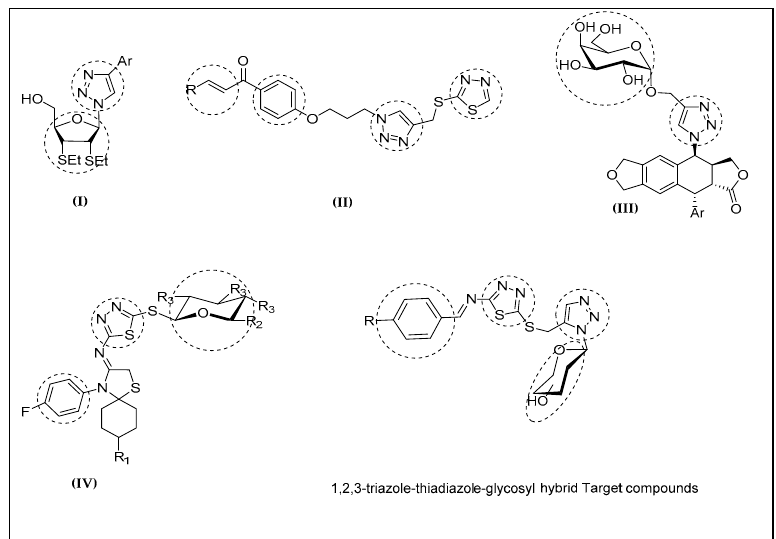
Figure 1. Anticancer 1,2,3-triazole glycosides ( I , II , and III ), 1,3,4-thiadiazole glycosides ( IV ), and targeted hybrid compounds.